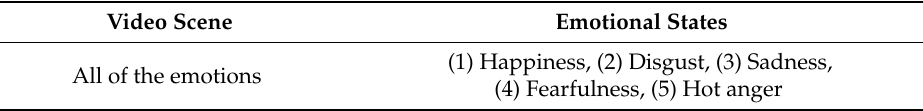
Table 2. Configuration of the